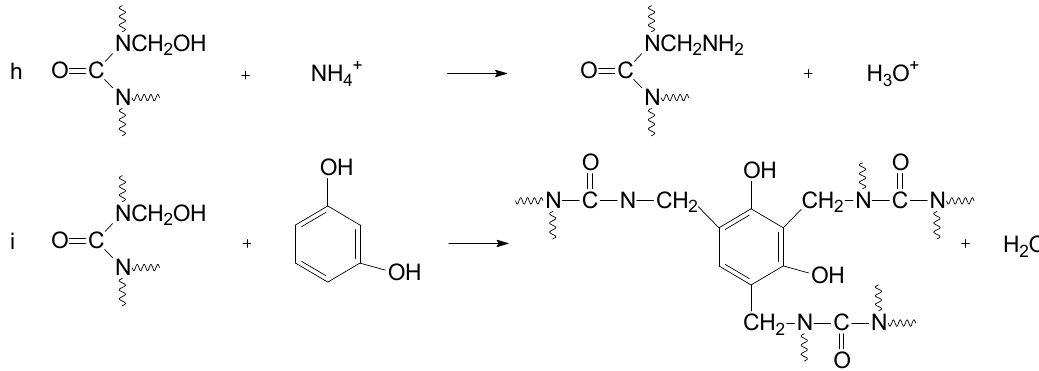
Figure 9. DSC curves of heating ( A ) and cooling ( B ) process of microcapsules prepared with further addition of different amount of crosslinker.